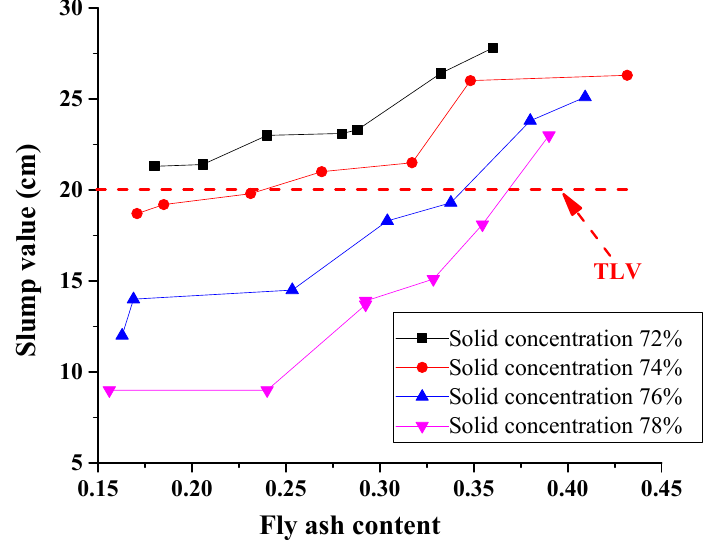
Figure 6. Effects of fly ash content on slump property of CPB slurry.